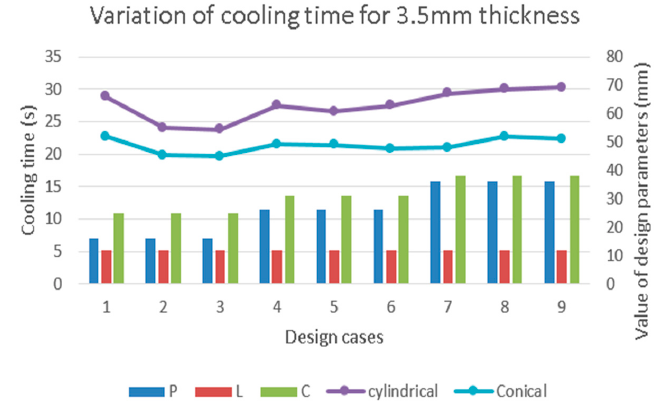
Figure 8. Cooling time variation for 3.5-mm thick plastic parts (both cylindrical and conical).